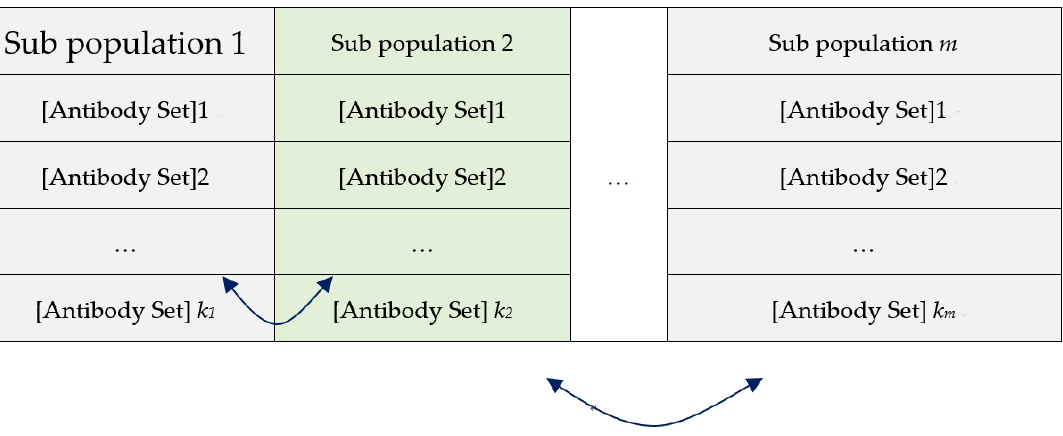
Figure 9. The antibody sets migration between populations of islands. The best solution is rendered by keeping migration with good antibody sets in different islands to exchange and substitute with part of antibody sets in other populations over time. The migration will be selected according to a predefined probability (migration rate).